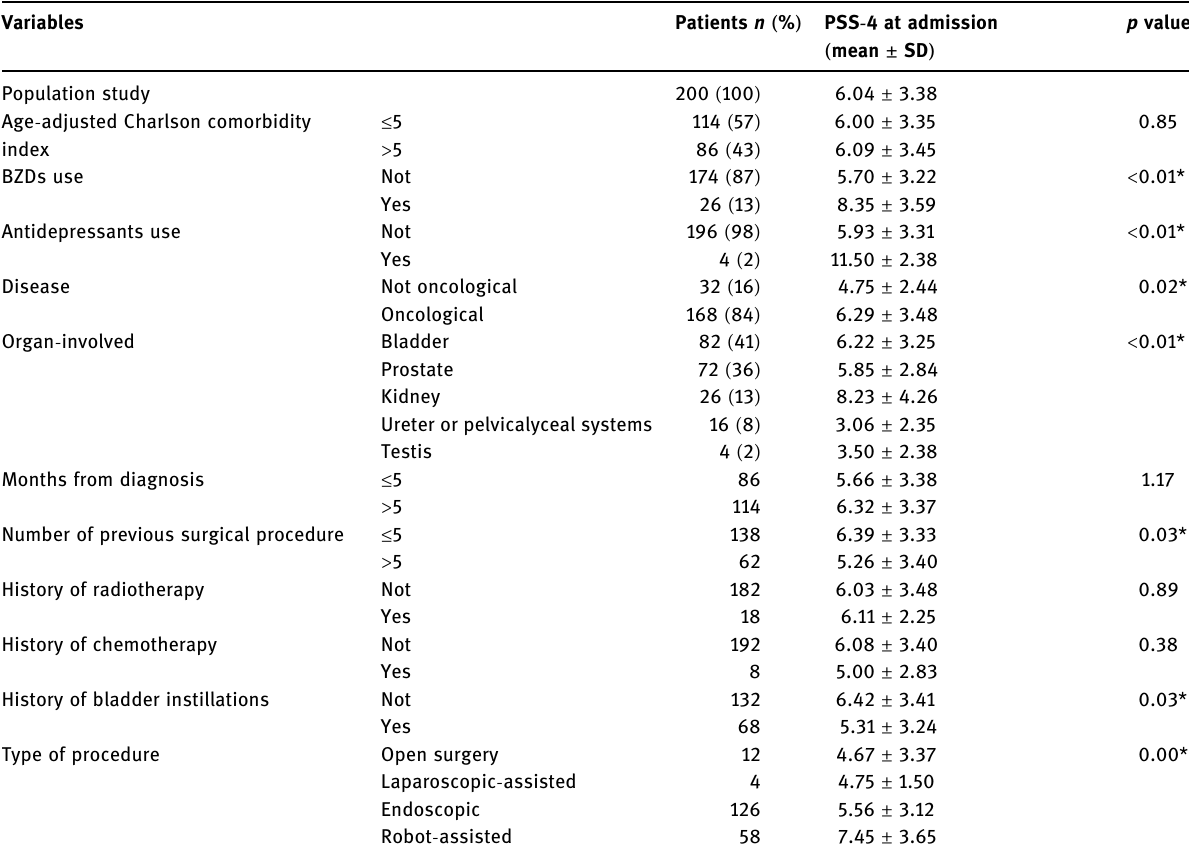
Table 2: Medical history data and univariate analysis of mean values of PSS - 4 at hospital admission Variables